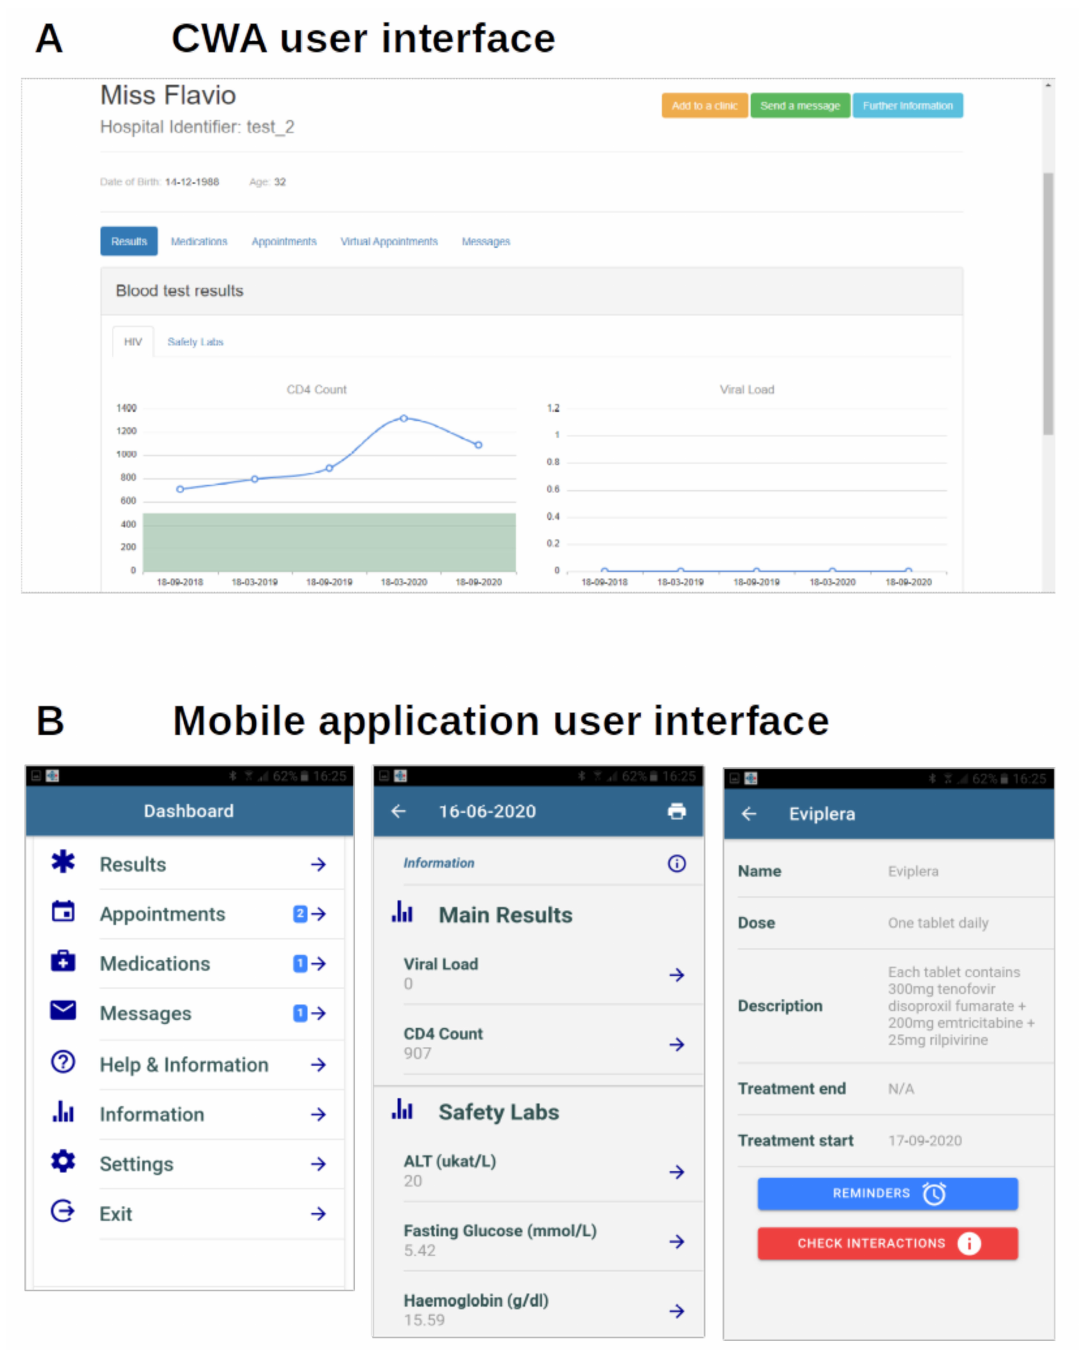
Figure 2. CWA ( A ) and Mobile Application ( B ) User